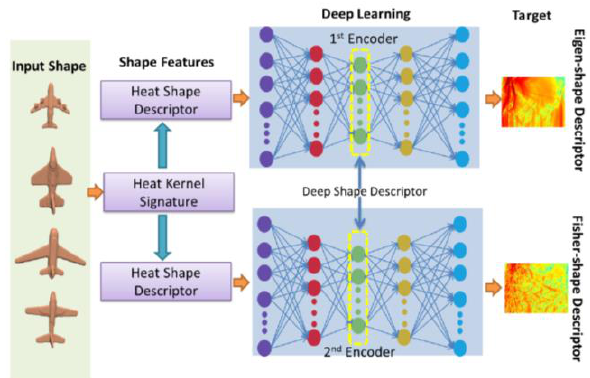
Figure 3. The automatic extraction workflow of shape descriptors presented in (Fang et al.,